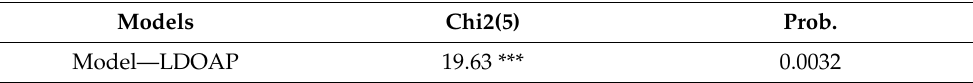
Table 9. Hausman test. Models Chi2(5) Prob.